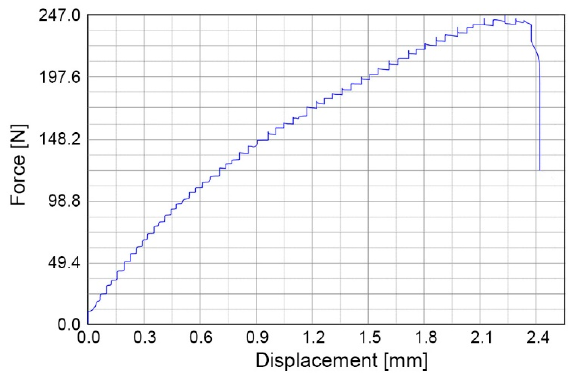
Figure 5. Loading cycle of shear strength test of PMMA–PC microchips.